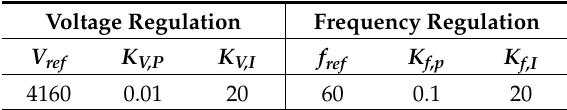
Table 4. The Coefficients of Secondary Controllers.